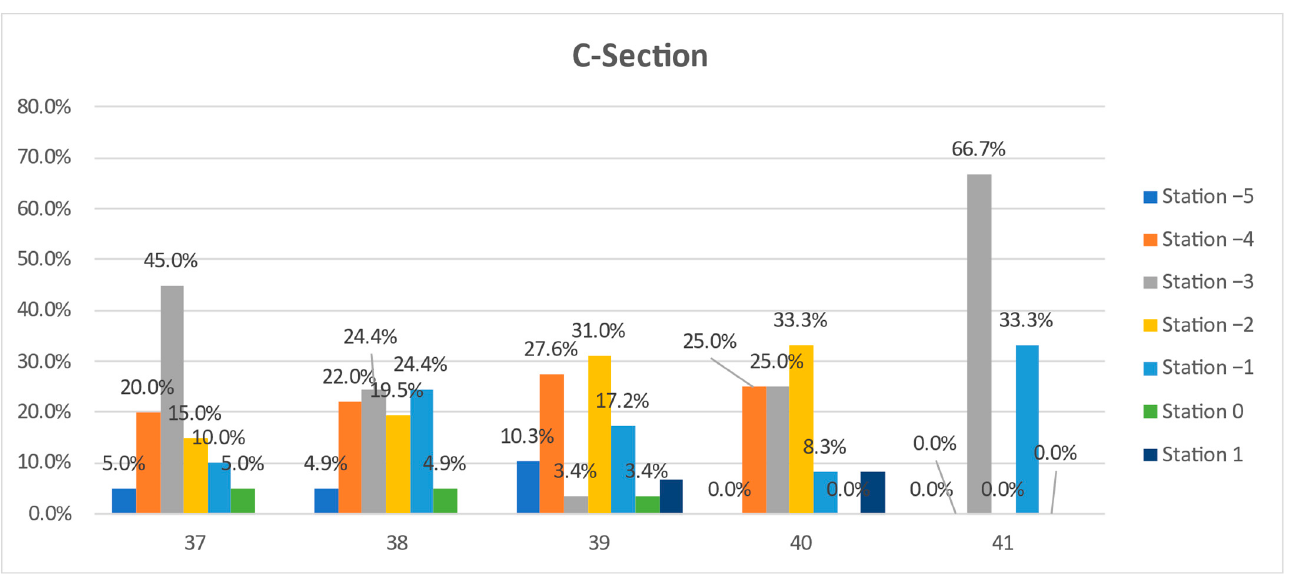
Figure 4. The comparative distribution of the clinical fetal head station at 37 to 41 weeks of gestation in the Cesarean delivery group.